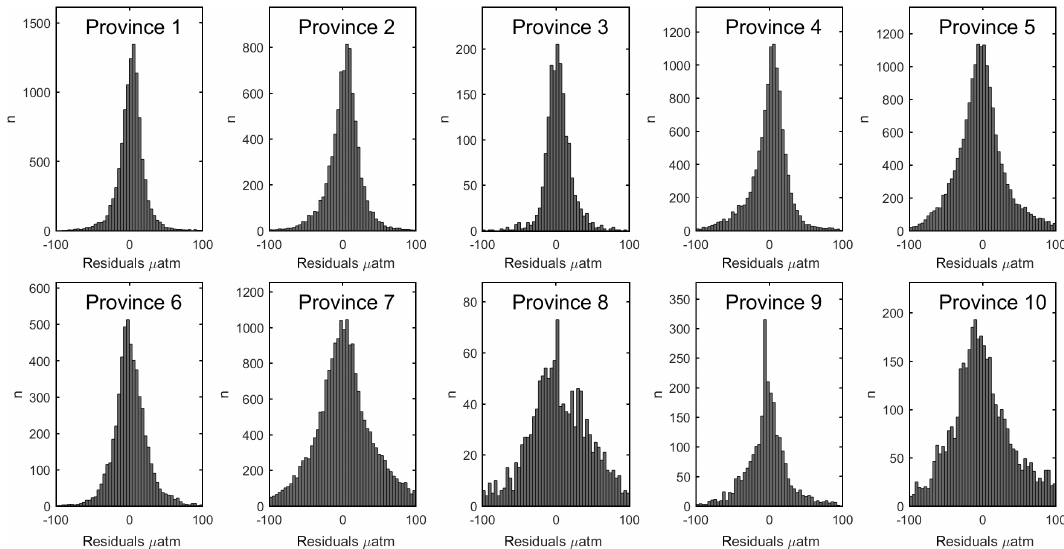
Figure 6. Histograms reporting the distribution of residuals between observed (LDEO ∗ ) and computed (SOM_FFN) p CO 2 in each biogeo- chemical